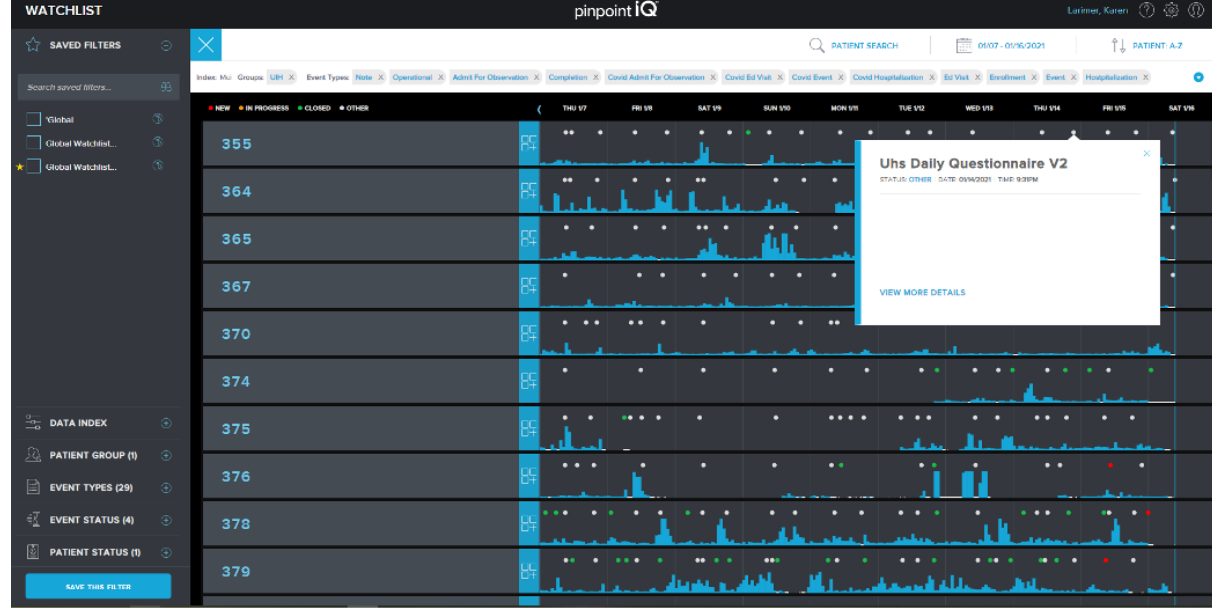
Figure 3. Daily patient reported-health surveys displayed to the clinical